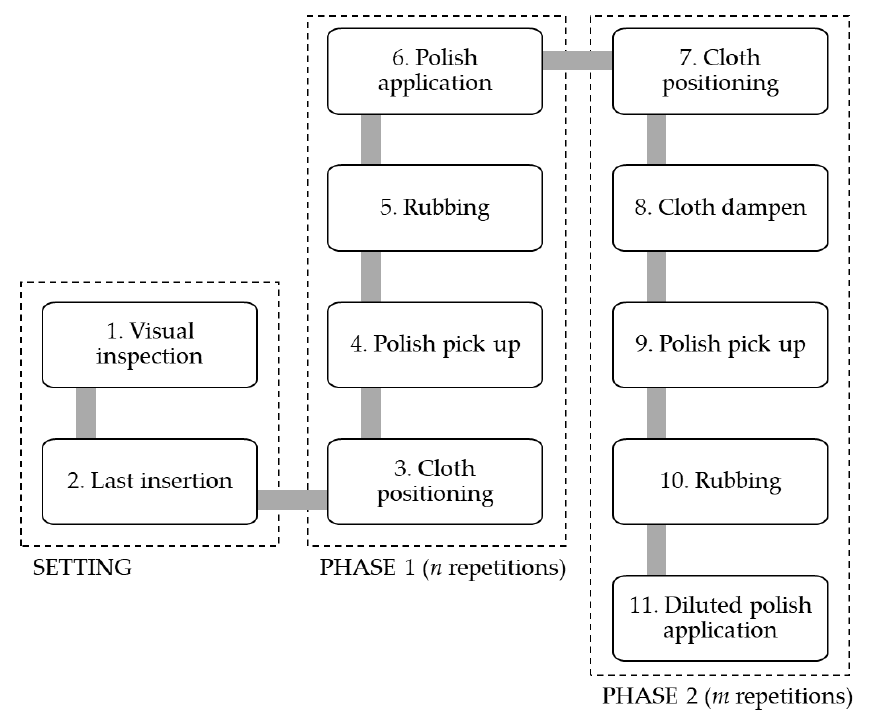
Figure 1. Polishing process of leather shoes.